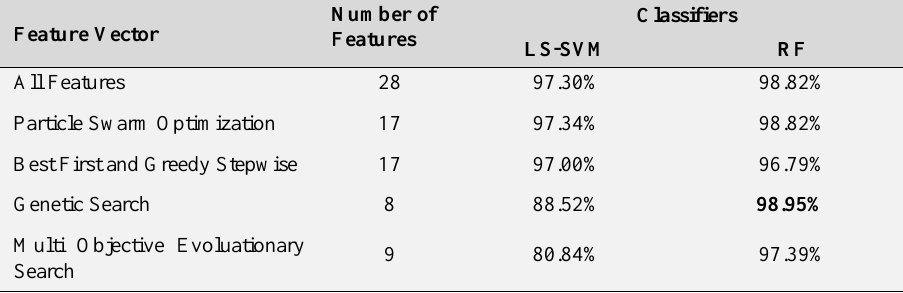
Table 4. Performances of the classifiers on the feature